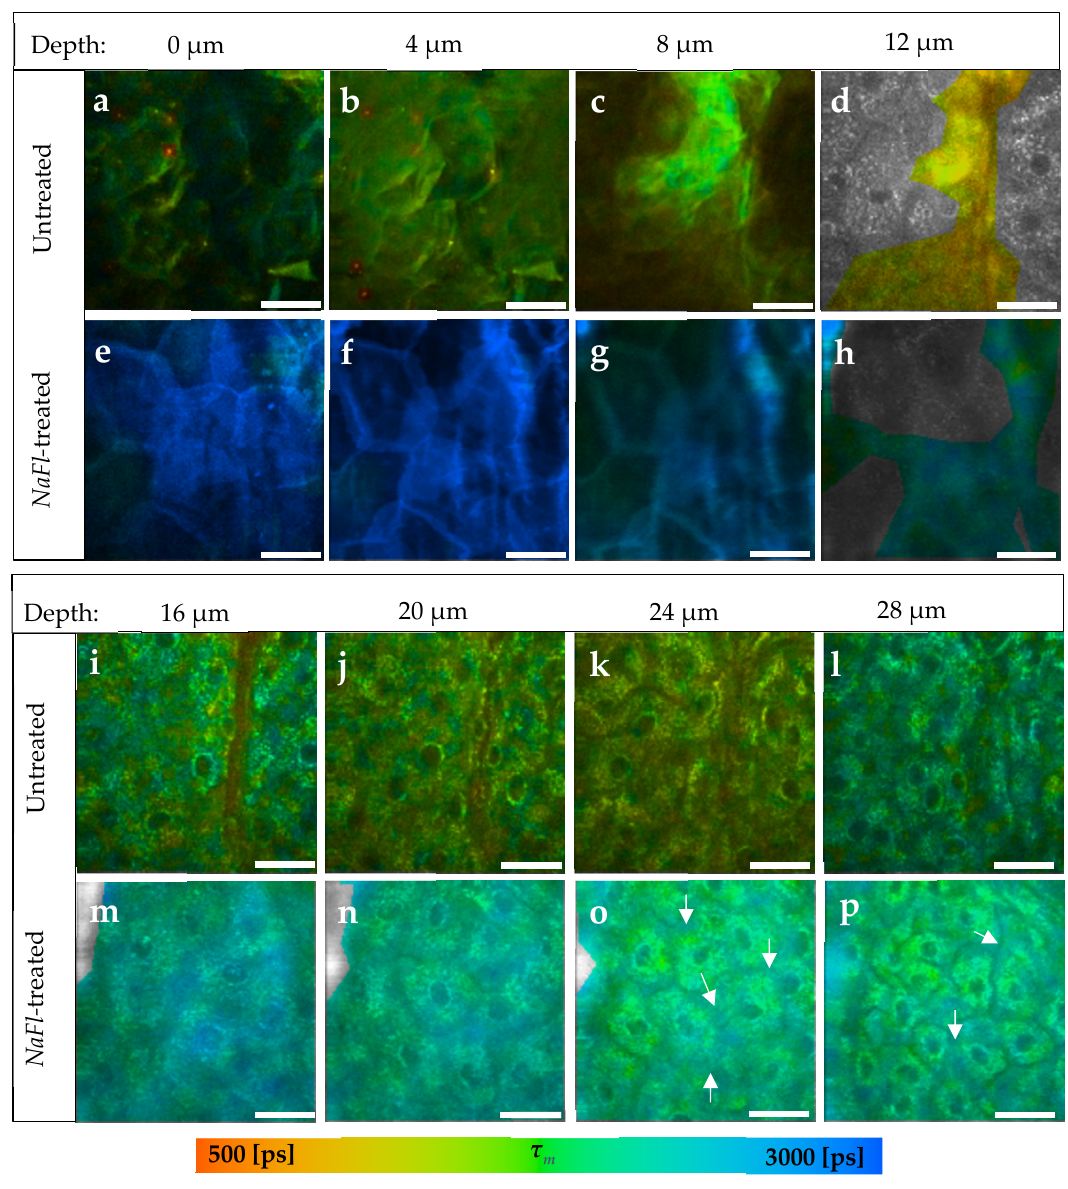
Figure 3. TPE-FLIM images of NaFl -treated compared to untreated skin at different depths. ( a – d ) The SC of the untreated skin; ( e – h ) The SC of NaFl -treated skin. The treated SC showed an average increase in τ m from τ m = 1522 ± 89 to τ m = 2725 ± 210 ps; ( i – l ) The viable epidermis of the untreated skin; ( m – p ) The viable epidermis of the NaFl -treated skin; ( o , p ) The white arrows refer to the extracellular areas between the keratinocytes. τ m was measured after an excitation with 760 nm using a TPT and is shown by a pseudocolor scale of 500–3000 ps. Scale bar: 20 μ m. Acquisition time: 6.8 s. Excitation power is depth-dependent and shown in Table 1.